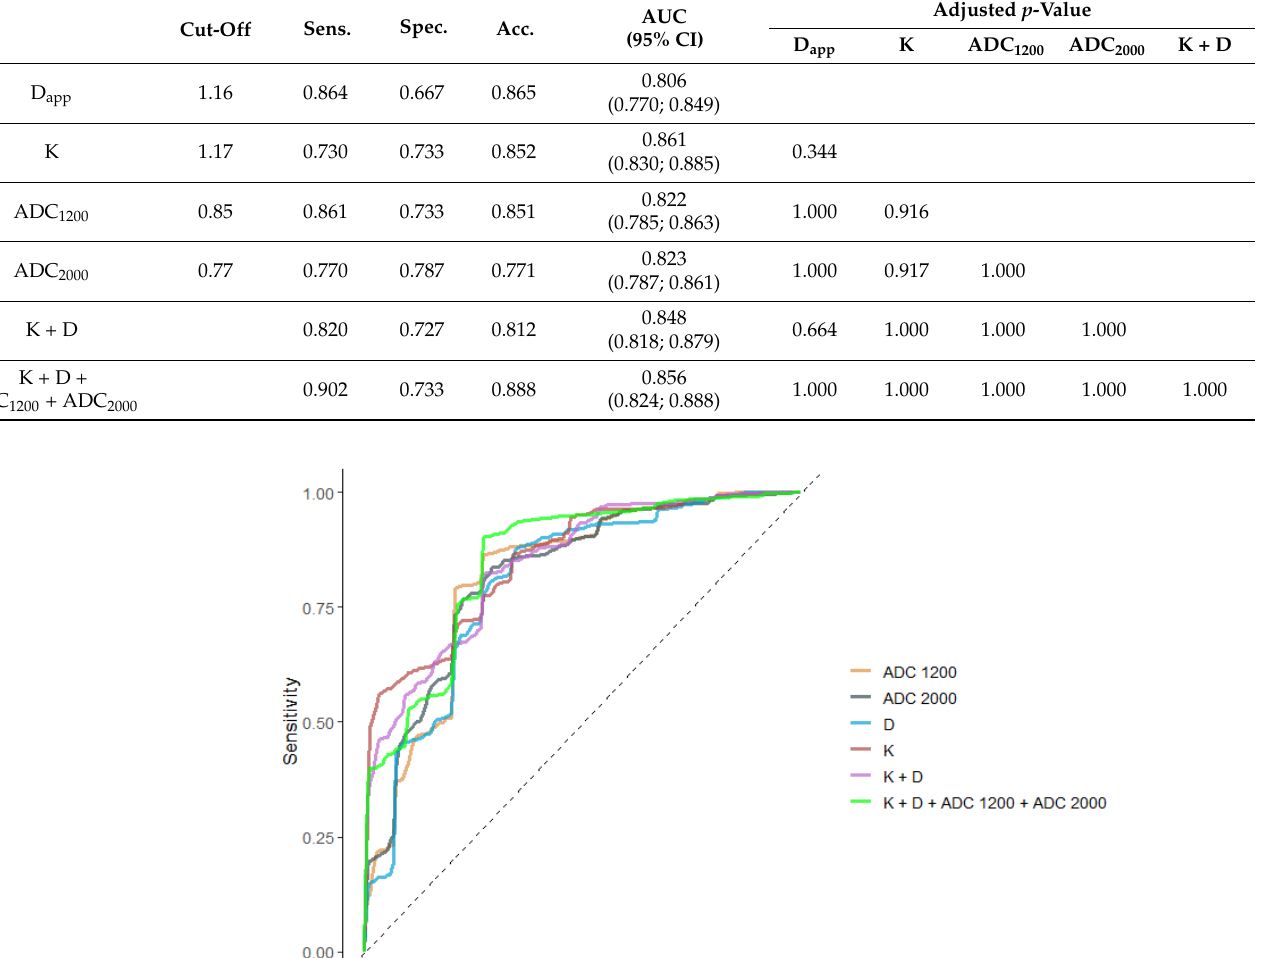
Table 4. Diagnostic performance in differentiating GS ≤ 3 + 3 and GS ≥ 3 + 4 tumors of D app , K, ADC 1200 , and ADC 2000 , the combination of D app and K together, the combination of D app + K + ADC 1200 + ADC 2000 together, and cut-off values for D, ADC × 10 − 3 mm 2 /s) and K determined by Youden index.